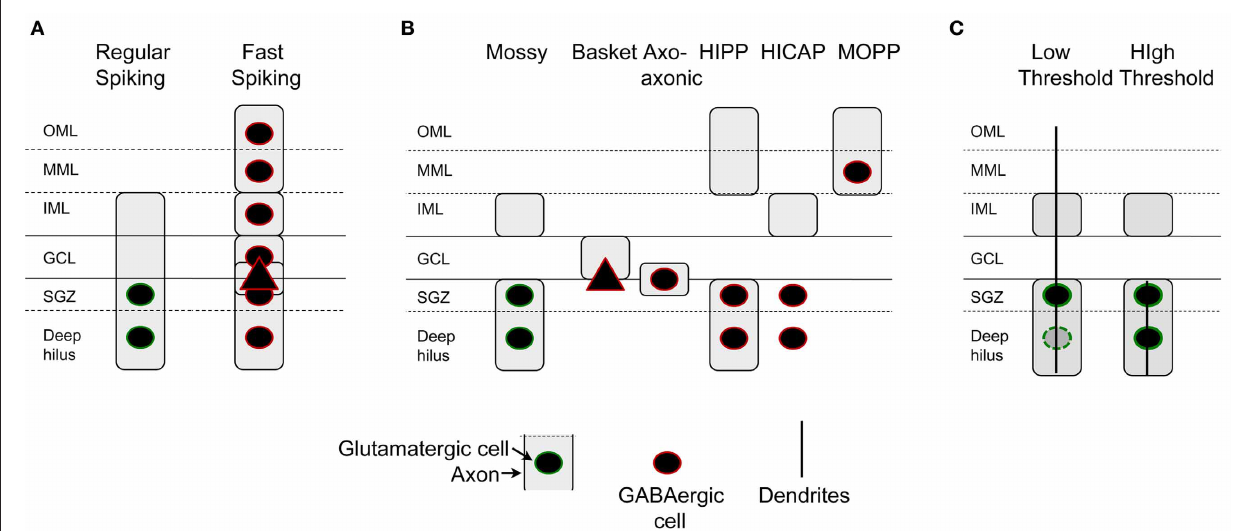
FIGURE 7 | Characterization of dentate gyrus non-granule cells. (A) Intrinsic electrophysiology of DG non-granule cells include two classes primarily, those cells that are regular-spiking and those that are not. Regular-spiking cells are mossy cells with hilar cell bodies and an axon in all layers but the outer and middle molecular layers. Fast-spiking cells are found in all layers and have axons that are in all layers. (B) Axon location indicates at least six types of non-granule cells. GABAergic neurons include basket cells, typically with a pyramidal